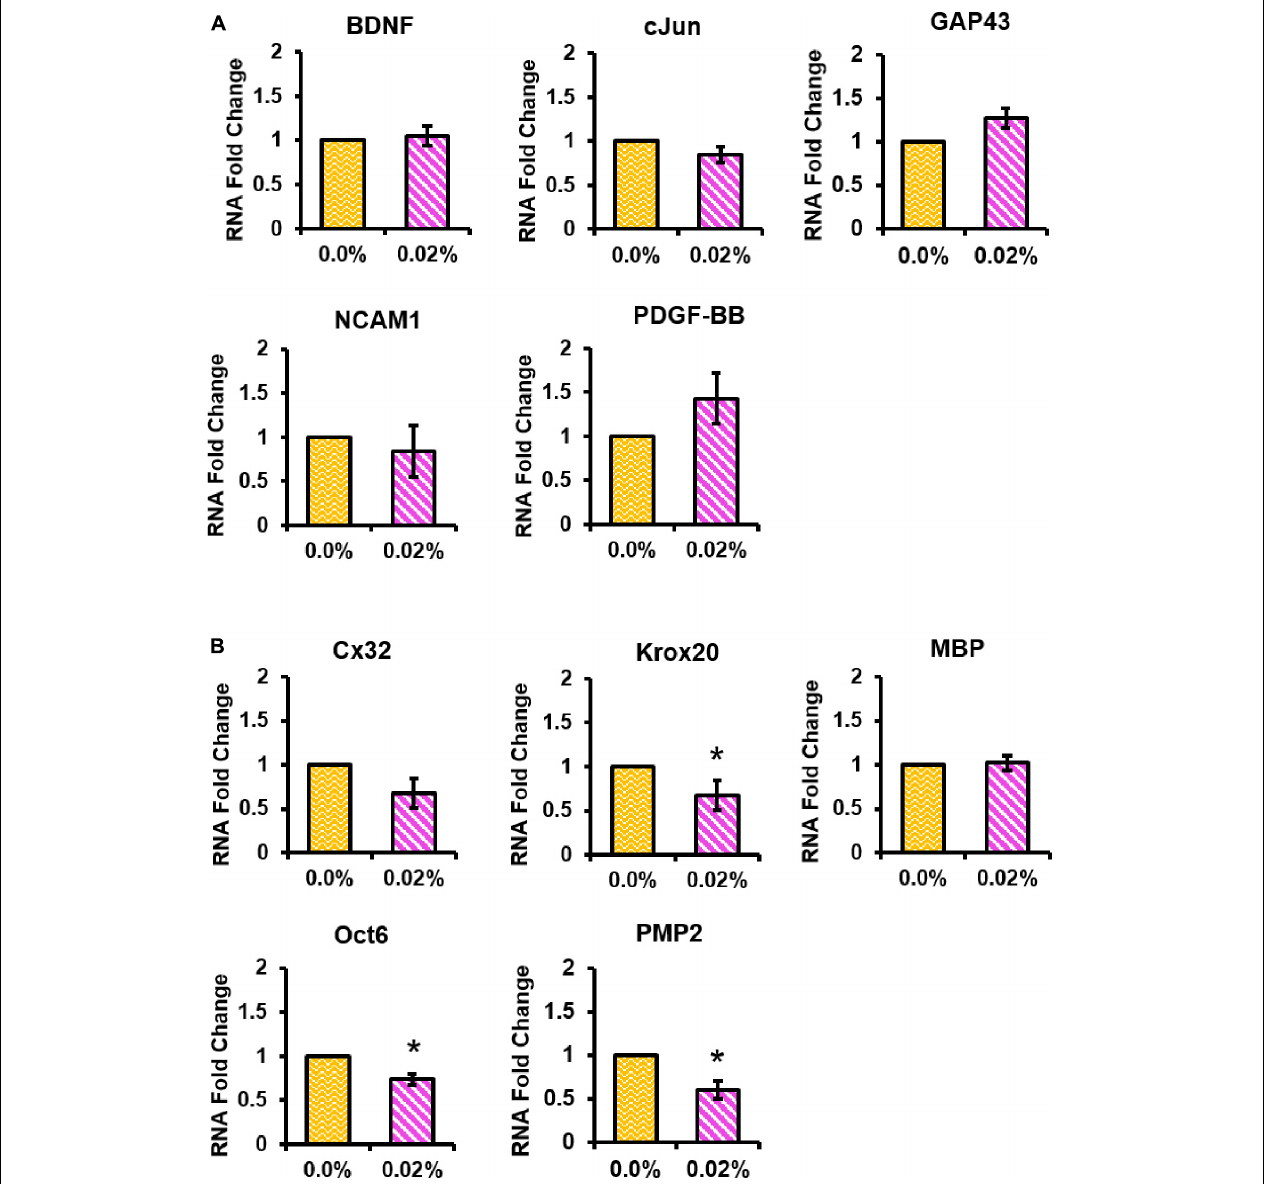
FIGURE 8 | The 0.02% fingolimod-loaded electrospun fibers significantly decreased Schwann cell expression levels of several promyelinating factors. qPCR was conducted to determine Schwann cell mRNA expression levels of the (A) regenerative factors BDNF, cJun, GAP43, NCAM1, and PDGF-BB and the (B) myelinating factors Cx32, Krox20, MBP, Oct6, and PMP2. Schwann cell gene expression data are represented by the mean RNA fold change ± standard deviation. Statistical significance was assessed using general linear regression (* p <